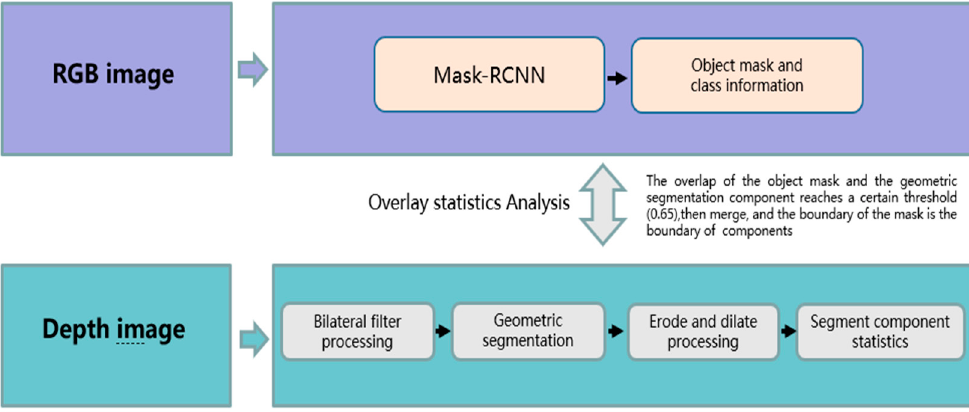
Figure 3. Flowchart of object instance segmentation based on geometric and semantic cues.